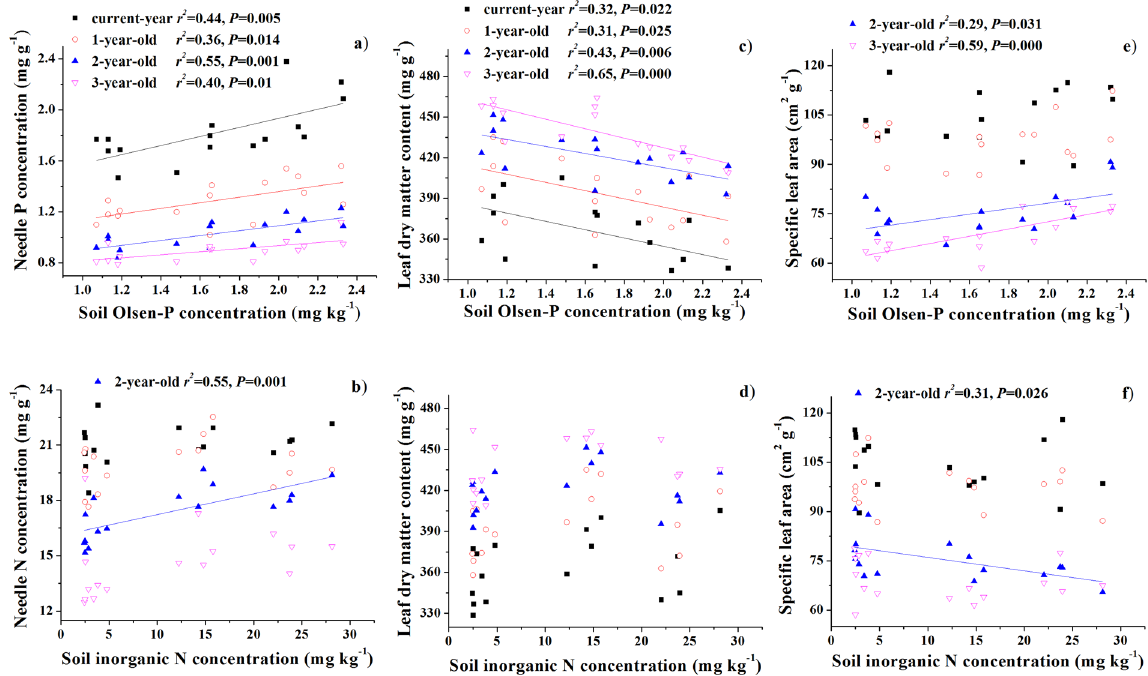
Figure 3. Relationships between needle traits and soil properties (inorganic N and Olsen-P) in a Mongolian pine plantation. The data were fitted by linear regression, and fitted regression lines denote significant regressions ( p <